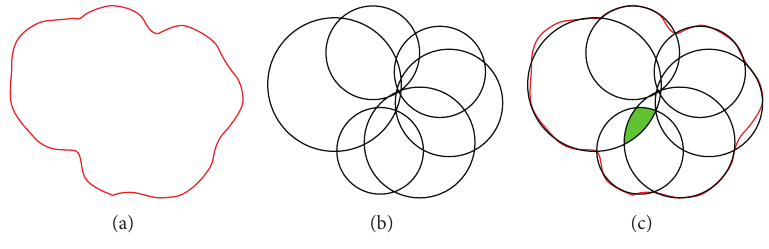
Figure 18: Simulating complex particle